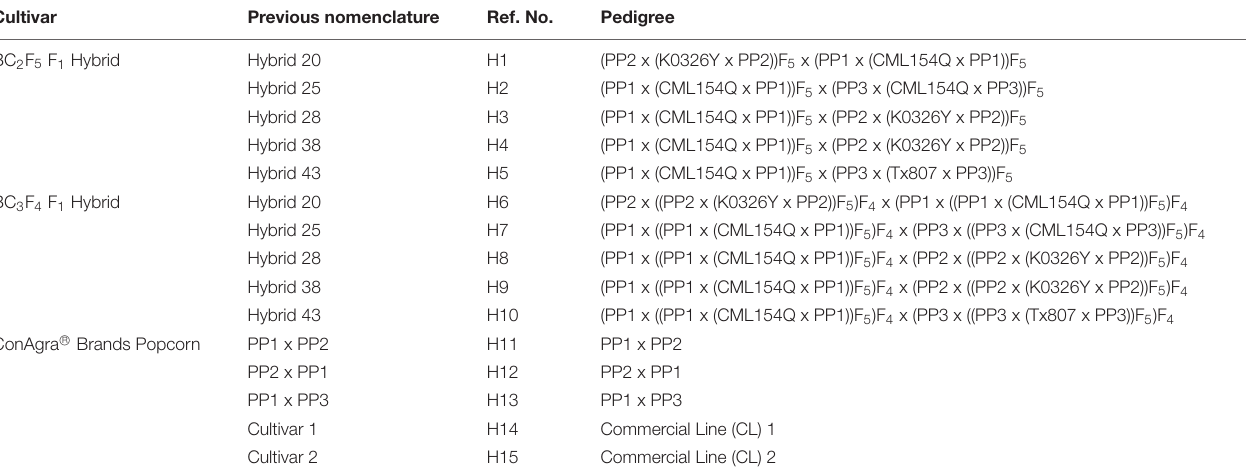
TABLE 1 | Description of cultivars tested in 2020 summer trials. Cultivar Previous nomenclature Ref.